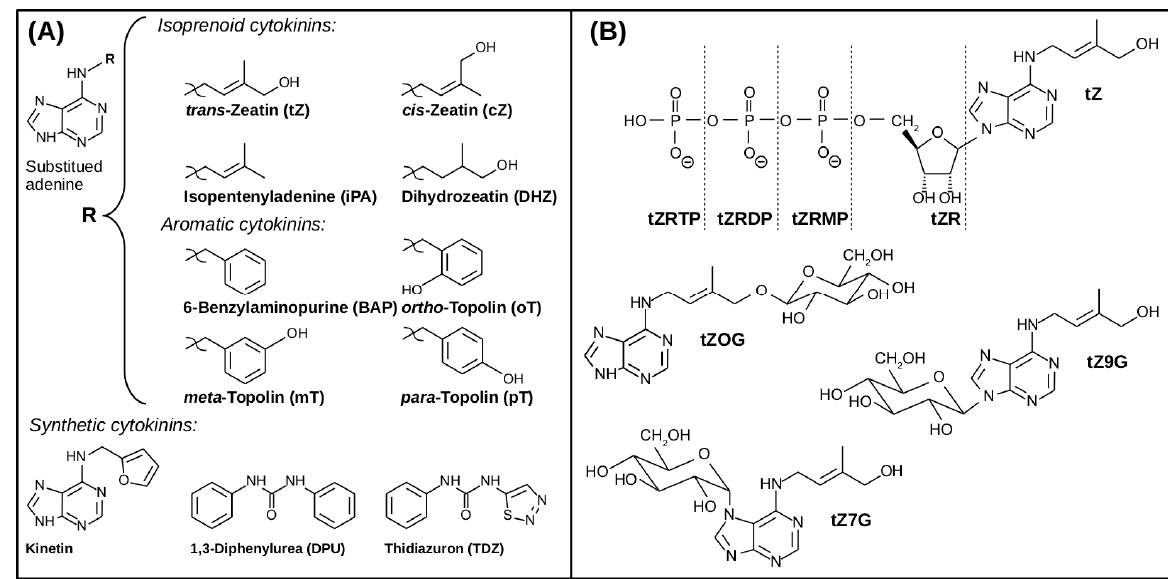
Figure 1. Structures of major cytokinins (CKs) in form of free bases ( A ) and different forms of trans -zeatin ( B ). Taken from [32]; tZR: trans -zeatin riboside; tZRMP: trans -zeatin riboside monophosphate; tZRDP: trans -zeatin riboside diphosphate; tZRTP: trans -zeatin riboside triphosphate; tZOG: trans -zeatin O -glucoside; tZ7G: trans -zeatin N 7 -glucoside; tZ9G: trans -zeatin N 9 -glucoside. Remaining abbreviations are explained in the figure.